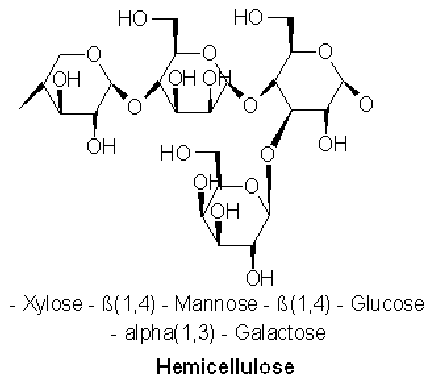
Figure 9. Most common molecular motif of hemicellulose